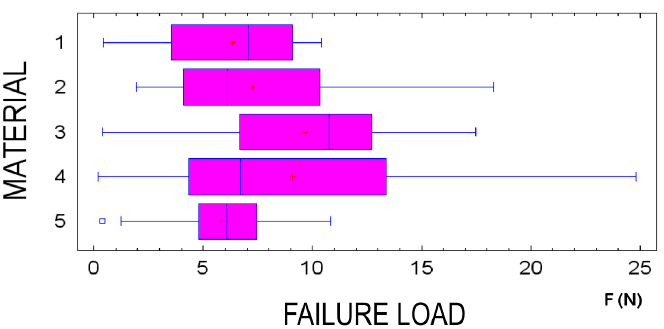
Figure 4. Comparison of suture material failure load in three knot configurations.